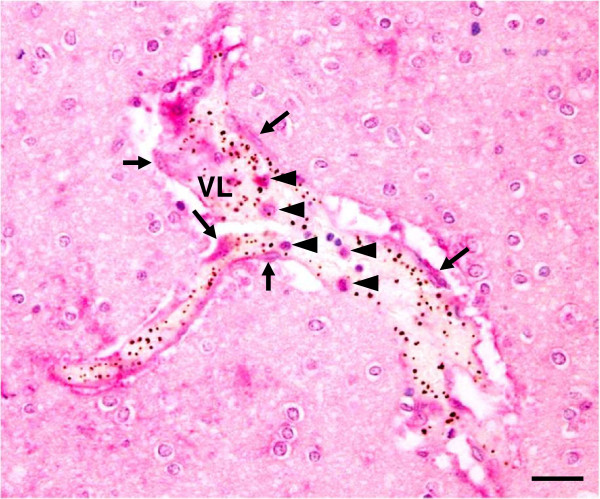
Immunohistochemical staining for cleaved caspase-3 in the blood vessel of fatal CM brain. A micrograph to demonstrate strong positive staining for cleaved caspase-3 in the ECs (arrows) sequestered with PRBCs and leukocytes (arrowheads) inside the vascular lumen. VL = vascular lumen. Scale bars = 20 μm.